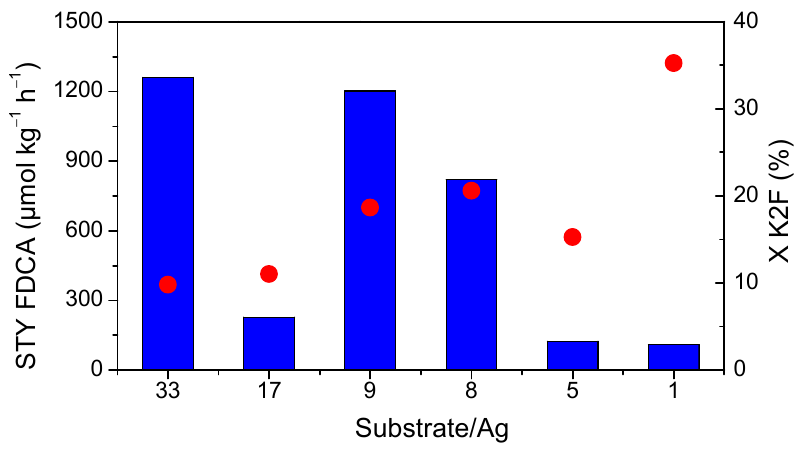
Figure 5. Effect of substrate/Ag molar ratio on the conversion of K2F ( • ) and the STY of 2,5-FDCA ( ■ ). (Conditions: Substrate/Ag = 1–33, F CO2 = 45 mL min − 1 , 20 rpm, T = 200 °C, t = 20 h.)